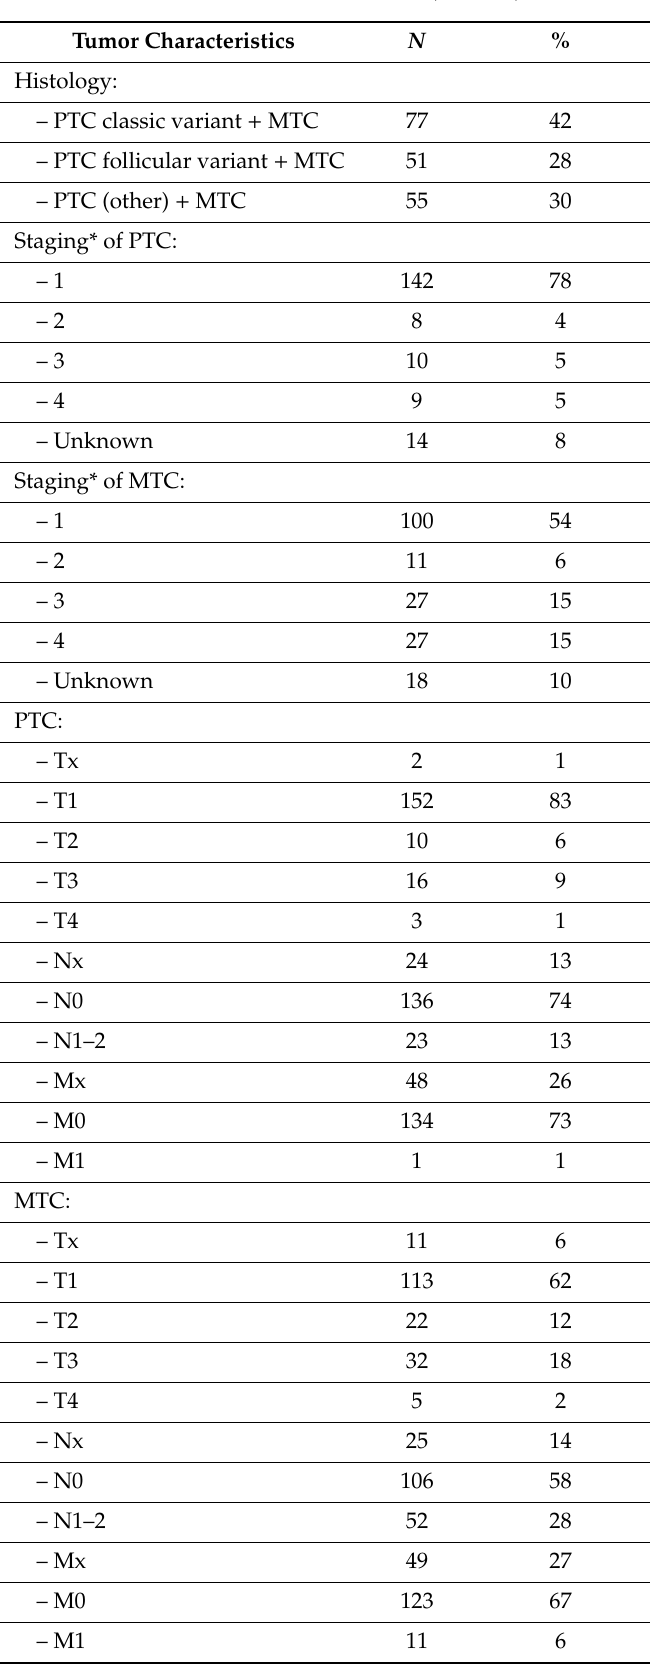
Table 2. Tumor characteristics ( N =